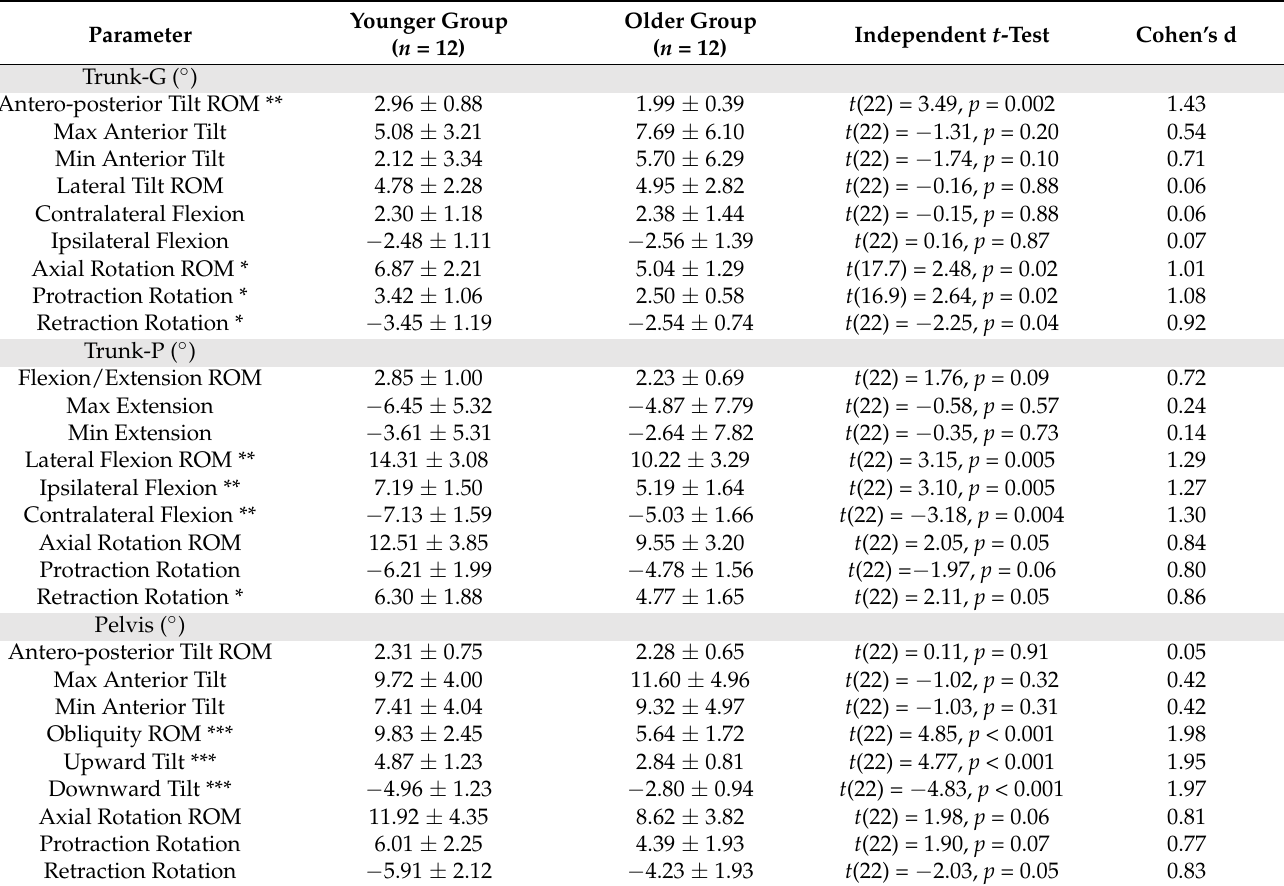
Table 2. Trunk and pelvic kinematic peaks and ROMs (mean ± SD) for the younger and older groups during normal walking